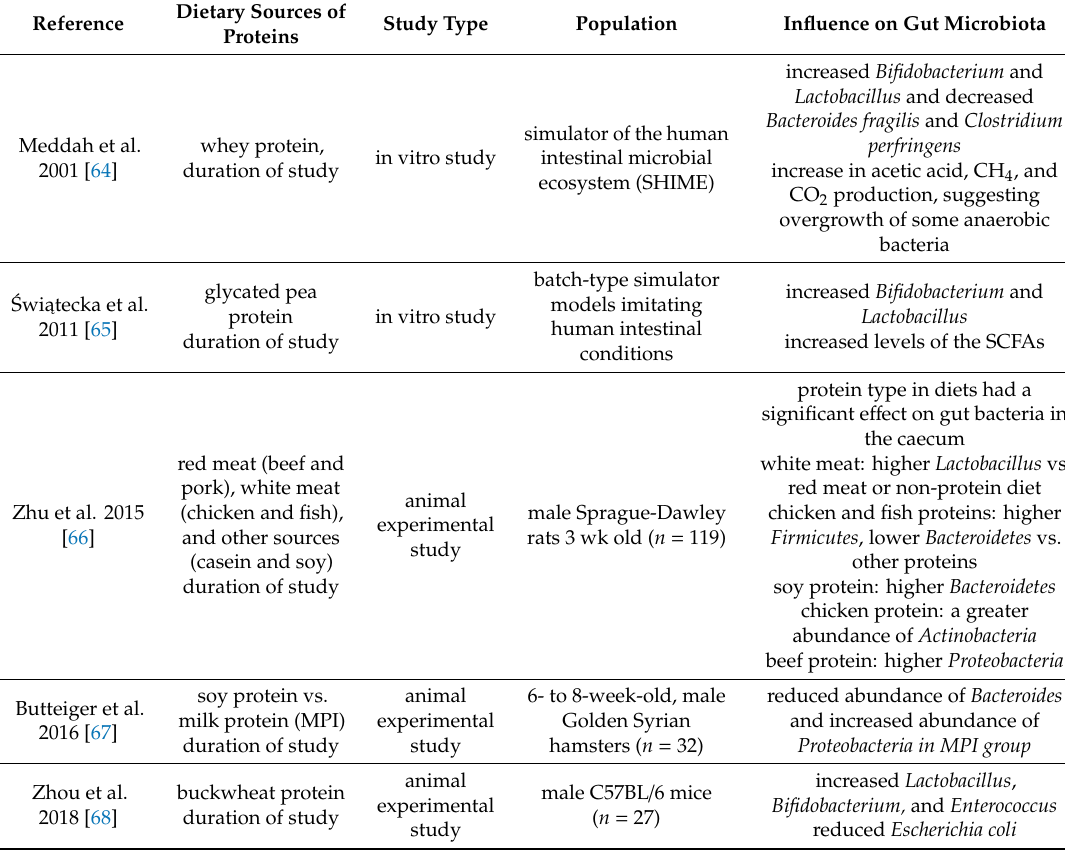
Table 2. Influence of di ff erent sources of proteins on